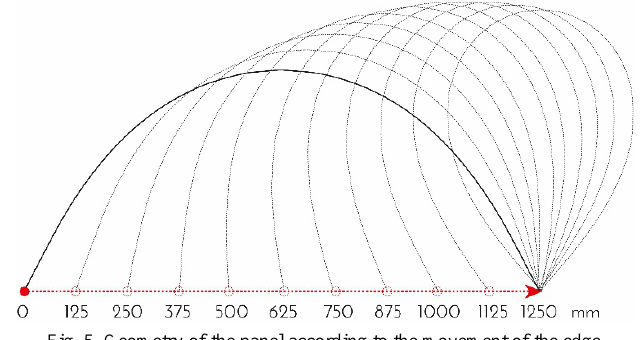
Fig. 5. Geometry of the panel according to the movement of the edge.